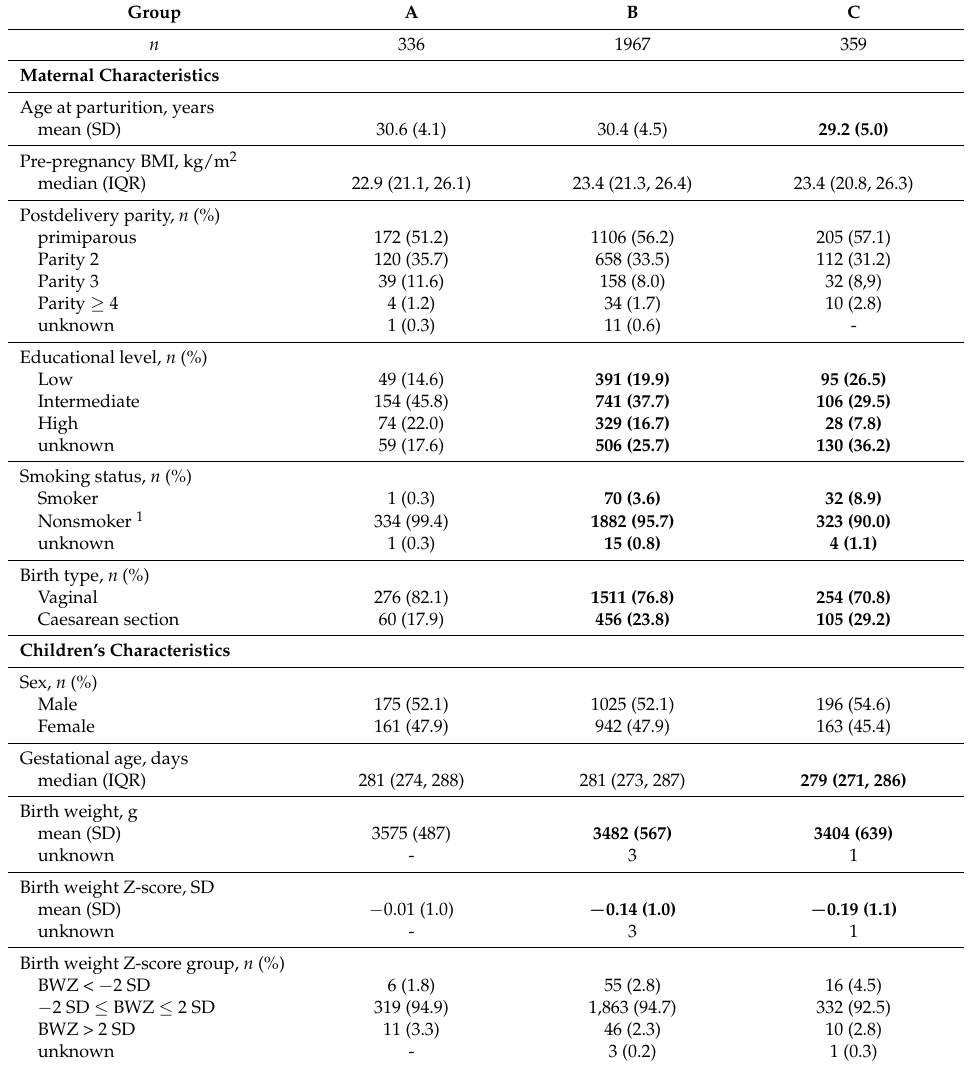
Table 1. Basic characteristics Mother-child dyads who ( A ) attended the physical examination at 4 months of age and delivered a breast milk sample of sufficient amount; ( B ) attended the physical examination at 4 months of age without delivering a breast milk sample; and ( C ) did not attend the physical examination at 4 months of age. Numbers in bold indicate values statistically significant different from group A ( p -values in main